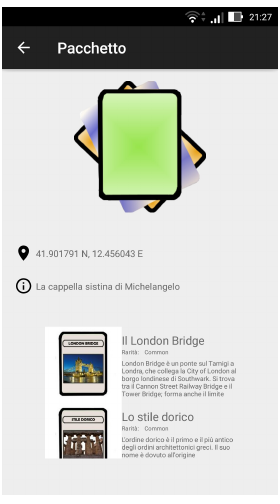
Figure 2. Treasure hunt mini-game